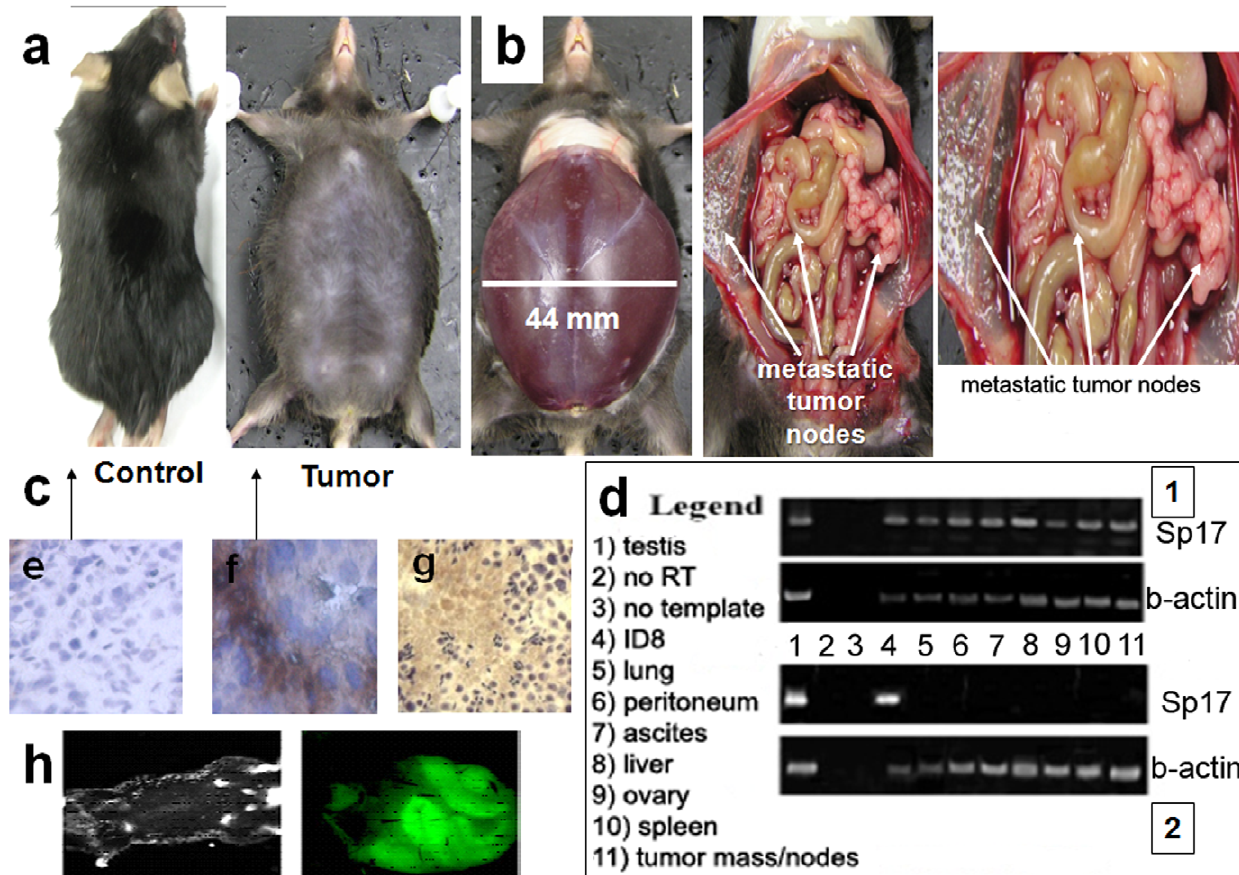
Figure 3. (a, b, c, d) Analysis of ID8 cells growth and dissemination in vivo. a shows on the left side a control mouse (width of mouse 20 mm) not injected with ID8 cells and on the right side a mouse injected with 2 6 106 ID8 cells after 40 days (width of mouse 44 mm). These mice represent experiments with similar results. b shows the full peritoneal cavity of ascites induced from an i.p injection of 2 6 106 ID8 in 40 days (left) and an open view of the cavity with several metastatic nodes and tumor masses (center and right, after aspirating 22 mL of ascites). c shows a peritoneum negative for Sp17 from a control mouse not injected with ID8 cells. f shows a positive expression of Sp17 on the peritoneum of a mouse injected with 2 6 106 ID8 cell after 40 days. Testis is the positive control for Sp17 by ICH ( g ). Figure d shows PCR for Sp17 DNA (and B-actin control): a tissue panel derived from (1) the organs of a 2 6 106 ID8 injected mouse was positive for Sp17 and a panel of tissues derived from organs of a healthy mouse revealed no expression of SP17. Positive controls (ID8 and testis) for Sp17 are also shown. Panel h shows in vivo fluorescence pictures of a control (left) and ID8-injected (right) mouse for the localization of GFP-positive ID8 cells.